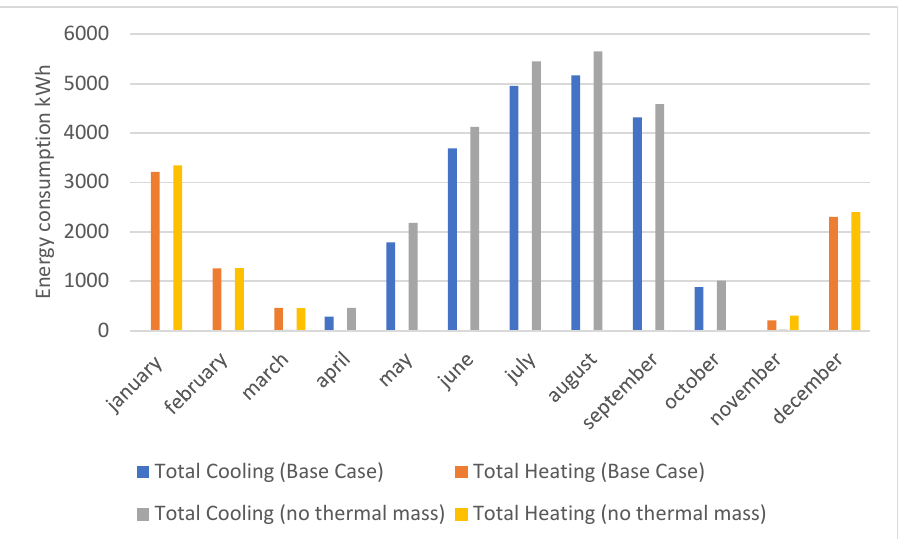
Figure 22. The annual energy consumption for Case 2 with modified thermal mass wall to imitate the contemporary house’s exterior wall structure.